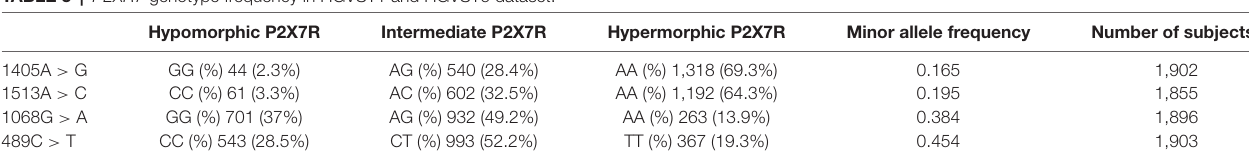
TABLE 3 | P2XR7 genotype frequency in HGVST1 and HGVST6